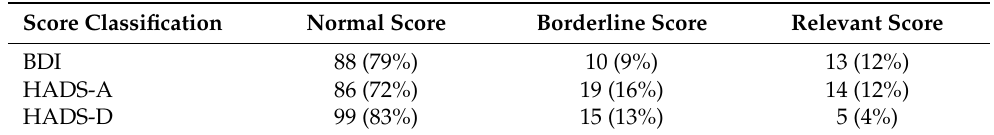
Table 5. Distribution of BDI as well as HADS-A and HADS-D scores in the population. Values are frequencies (%).